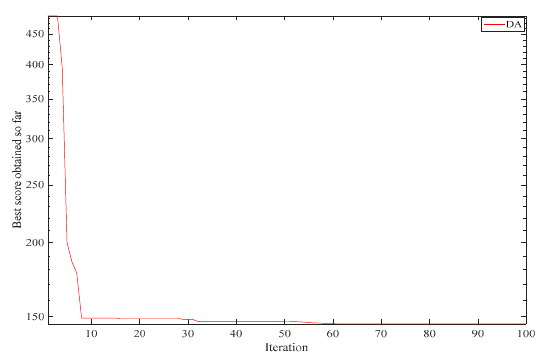
Figure 11. Iterative result diagram of dragonfly algorithms in island operation mode.